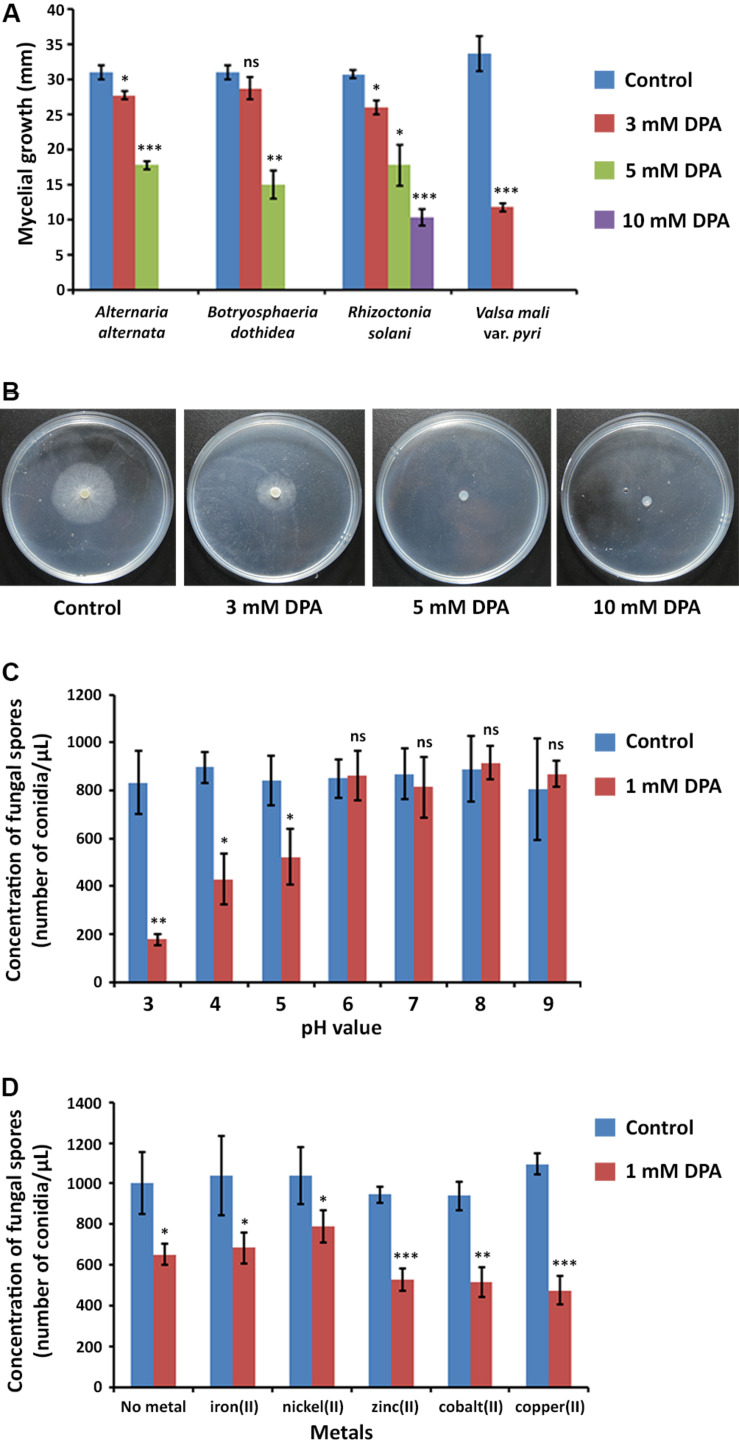
Antifungal properties of DPA. (A) Antifungal activity of DPA against canker pathogens A. alternata, B. dothidea, R. solani, and V. pyri. The antifungal activity was calculated according to the mycelial growth of the fungi (blue color) and the mycelial growth of the fungi in the presence of 3 mM (red color), 5 mM (green color) and 10 mM (purple color) DPA. (B) Mycelial growth of V. pyri in the presence of 0, 3, 5, and 10 mM DPA. DPA could block the growth of V. pyri at 5 mM concentration (pH = 5.6). (C) pH-dependence of DPA (1 mM) antifungal activity. The antifungal activity was calculated according to the number of conidia/μL. DPA showed higher antifungal activity at acid pH values. (D) Effect of metals at 1 mM concentration on the antifungal activity of 1 mM DPA (pH = 5). The antifungal activity was calculated according to the number of conidia/μL. Zinc(II), cobalt(II) and copper(II) enhanced the antifungal activity. Significance levels at *P < 0.05, **P < 0.01, ***P < 0.001, and no significance (ns).